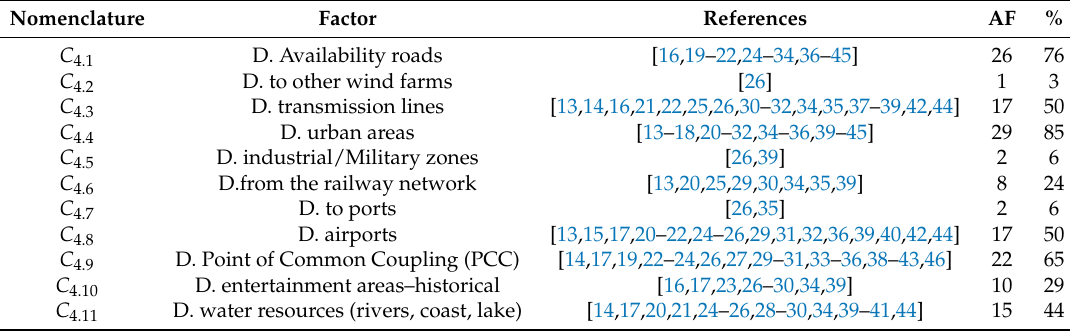
Table 10. Location Category ( C 4 )—Onshore wind energy. Quantitative analysis.